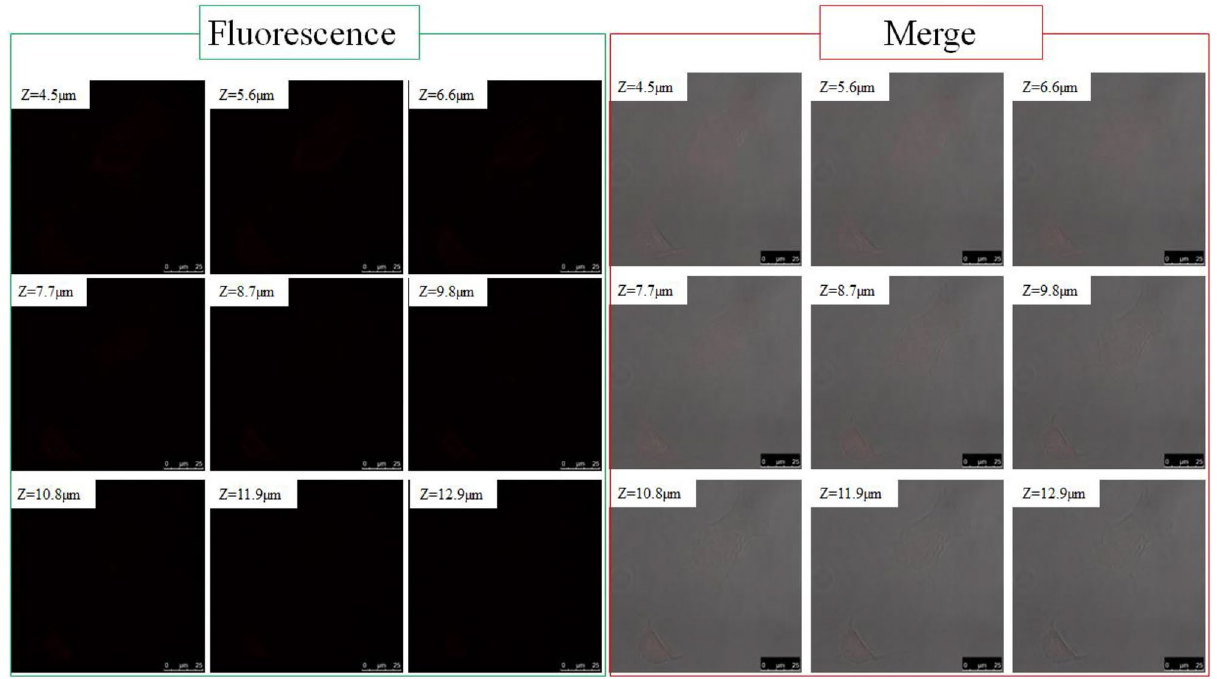
Figure 6. HeLa cellular uptake of UA-SiQDs with 25%-UA-coverage under confocal microscopy (Left: fluorescence. Right: overlap images). Slice scan of HeLa cells under confocal microscopy. Bar shows 25